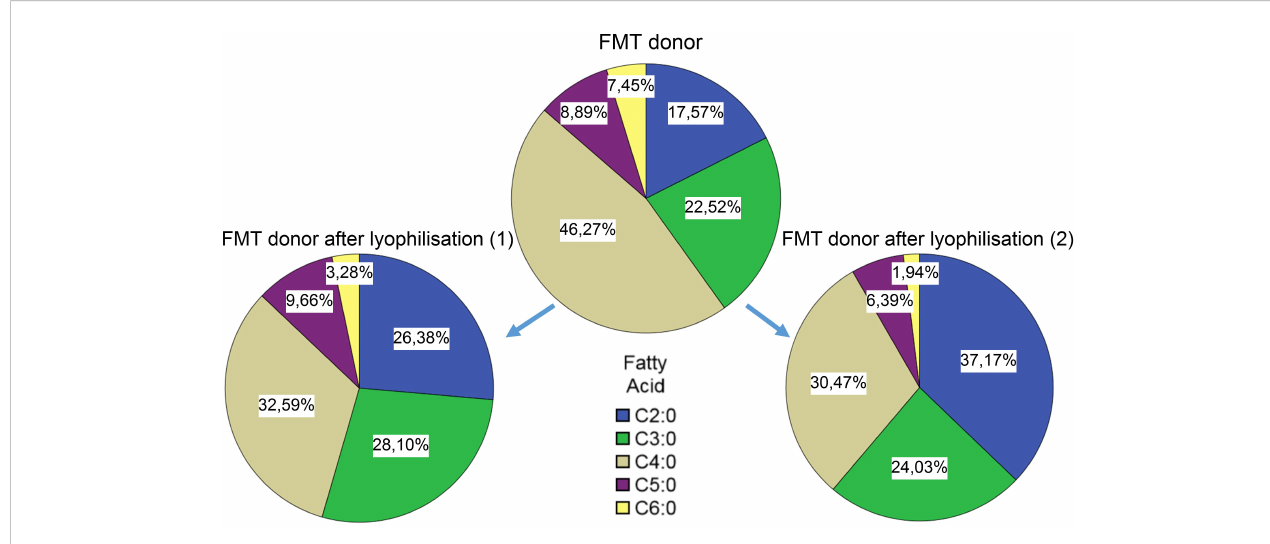
FIGURE 6 Short chain fatty acid compositions in donor samples before and after lyophilisation.